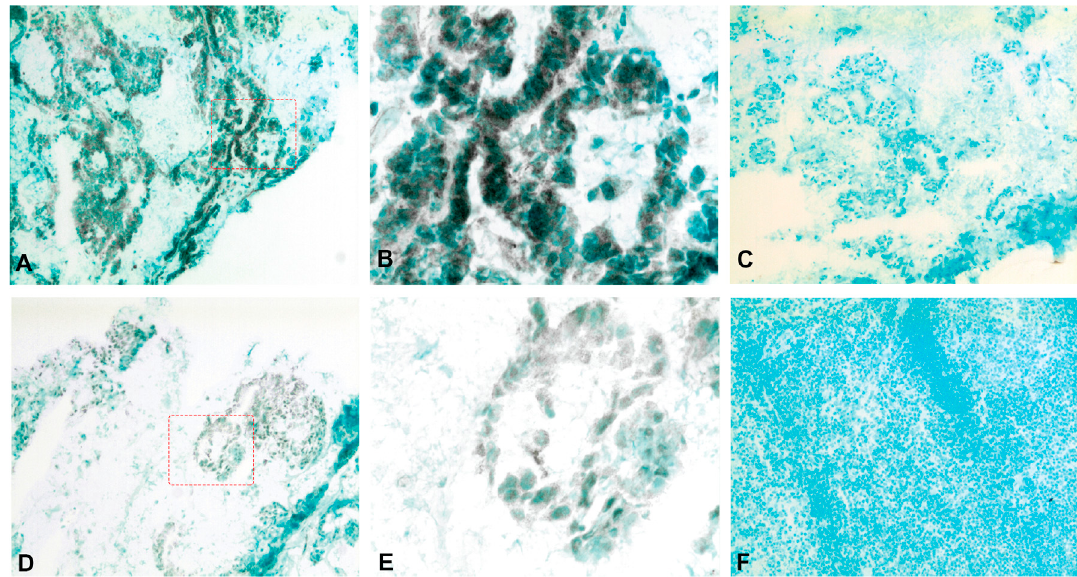
Figure 7. Immunoperoxidase staining of frozen lymph node tissue sections with metastatic colon cancer. ( A ) Anti-CXCL14 staining of an H&E( + ) lymph node of a CC patient, original magnification × 100. ( B ) Higher magnification of indicated area in (A), × 400. ( C ) Negative control of H&E( + ) lymph node of a CC patient, original magnification × 100. ( D ) Anti-CXCL16 staining of an H&E( + ) lymph node of a CC patient, original magnification × 100. ( E ) Higher magnification of indicated area in ( D ), × 400. ( F ) Anti-CXCL16 staining of an H&E( − ) lymph node of a CC patient, original magnification ×